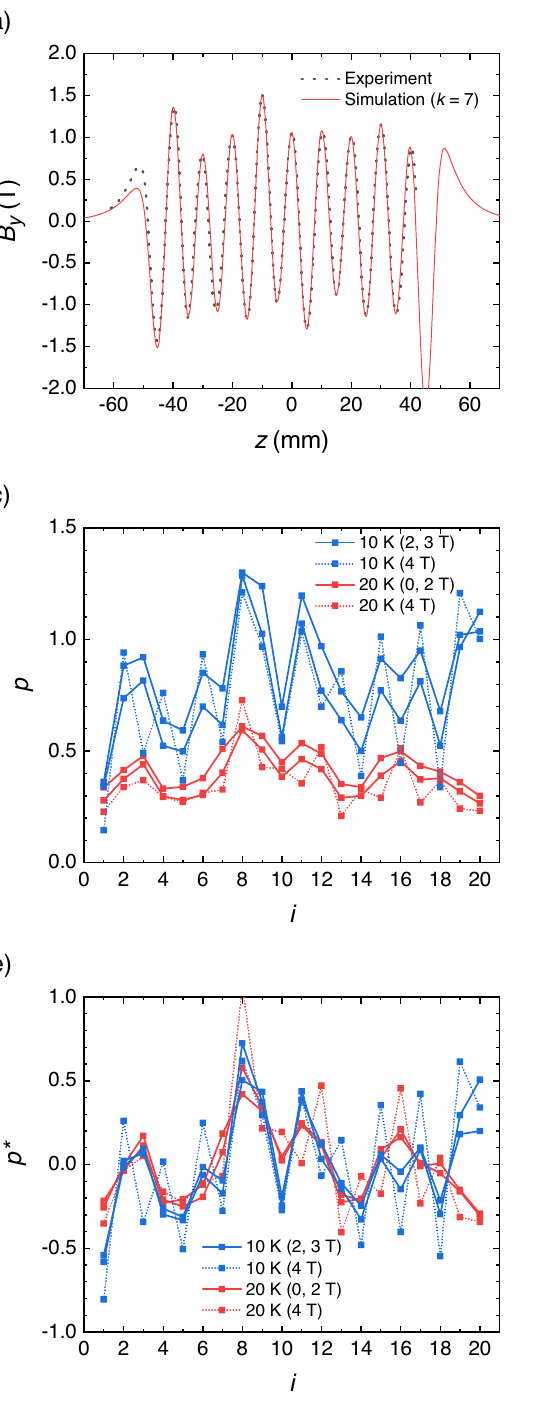
FIG. 8. Results of inverse analysis; (a) the comparison of measured and simulated B estimated p for each T and B ; each value of estimated (c) p and (e) p (cid:4) and (d, f) the local weighted average of these to cancel the s zigzag